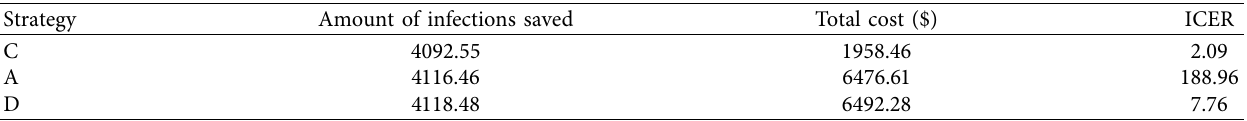
Table 7: Amount of the total infection averted and total cost used with ICER.